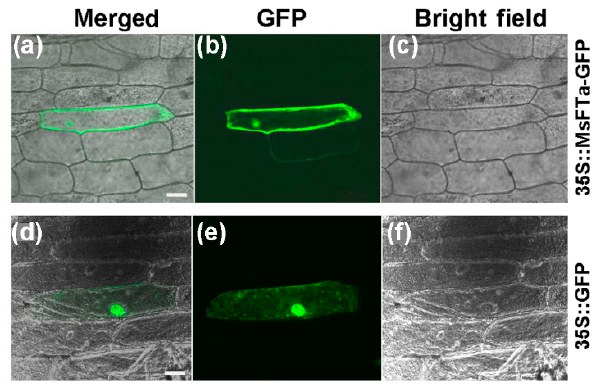
Figure 4. Subcellular localization of the MsFTa-GFP fusion protein in onion epidermal cells. The MsFTa-GFP fused construct and control vector pA7-GFP [29] were transiently transformed into onion epidermal cells by microprojectile bombardment. All images were captured using a confocal laser scanning microscope (Olympus FV500). ( a – c ): Image of onion epidermal cells expressing 35S::MsFTa- GFP taken under GFP fluorescence ( b ) or in bright field ( c ), the merged image was shown in ( a ); ( d – f ): Image of onion epidermal cells expressing 35S::GFP taken under GFP fluorescence ( e ) or in bright field ( f ), the merged one was shown in ( d ). Bar = 100 µm.